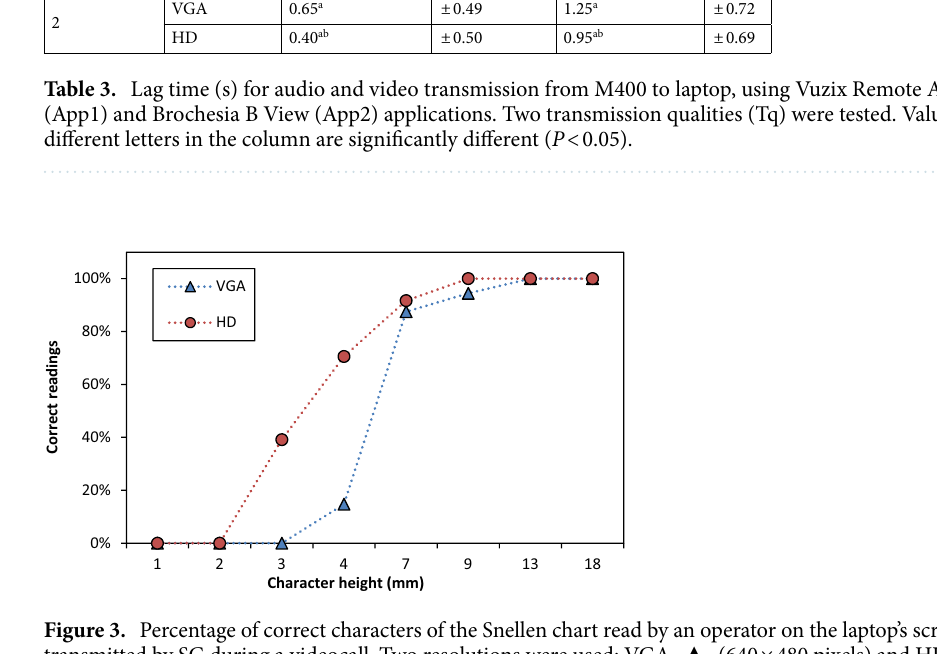
Figure 3. Percentage of correct characters of the Snellen chart read by an operator on the laptop’s screen and transmitted by SG during a videocall. Two resolutions were used: VGA - ▲ - (640 × 480 pixels) and HD - ● - (1280 × 720 pixels). The distance between the smart glasses camera and the chart was 0.5